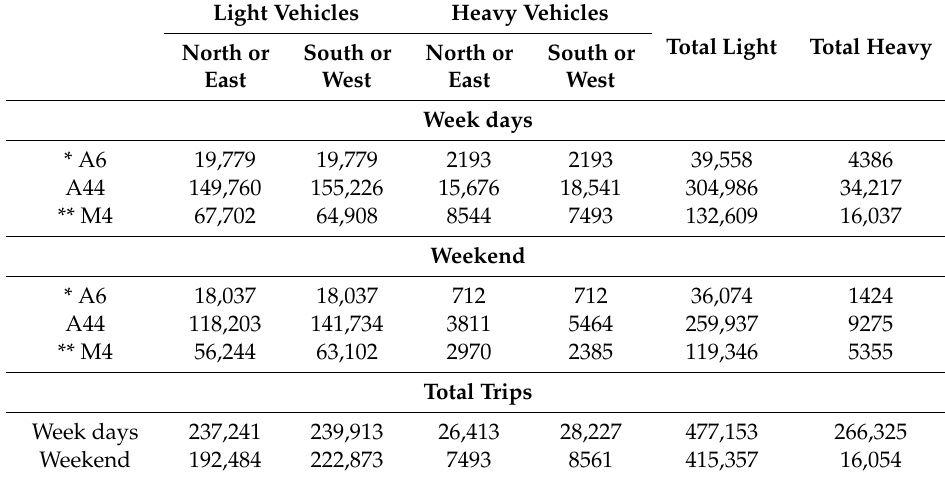
Table 1. Tra ffi c Statistics, average trips per day, for the major roads, A6, A44 and M4, to the east of the measurement site. Statistics have been taken from the camera-counters monitoring road tra ffi c on each